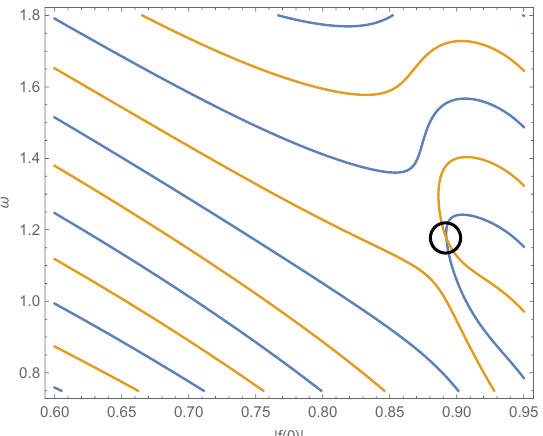
Figure 2 . Curves of vanishing real and imaginary parts of G ( !; j f (0) j ) in the d = 4 elliptic case. Only one solution can be spotted as an intersection. No other solutions have been found outside the range of this plot.